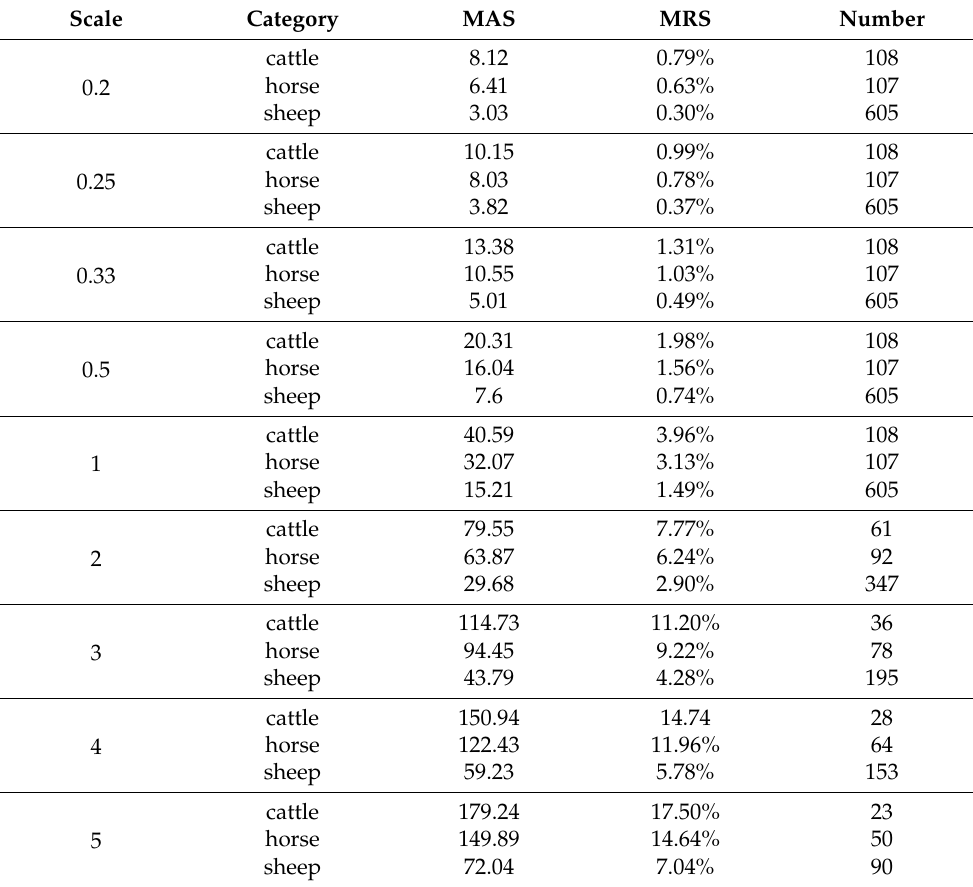
Table 3. Details of objects’ size in multi-scale